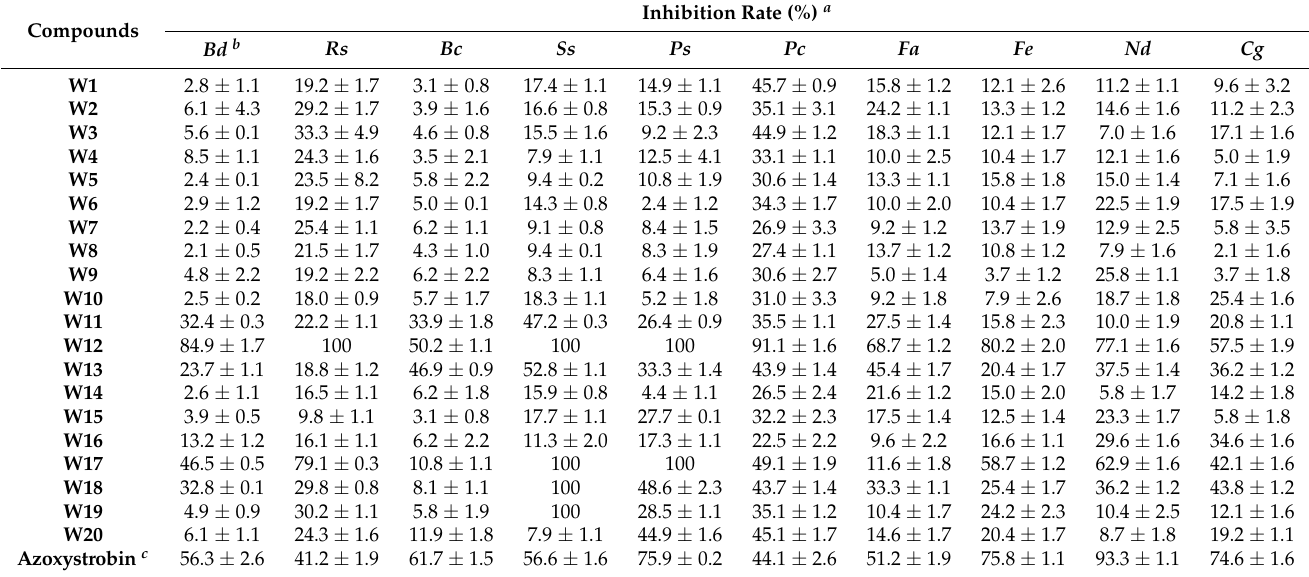
Table 1. In vitro antifungal activities of the title compounds W1 – W20 at 100 µ g/mL. Compounds